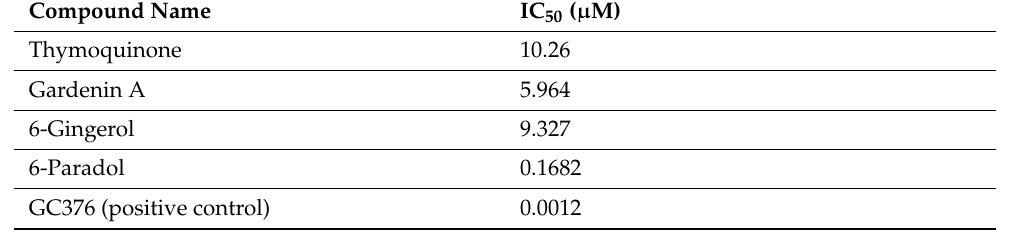
Table 3. IC 50 of isolated compounds compared to GC376 (Standard M PRO protease enzyme inhibitor) on SARS-CoV-2 viral main protease.